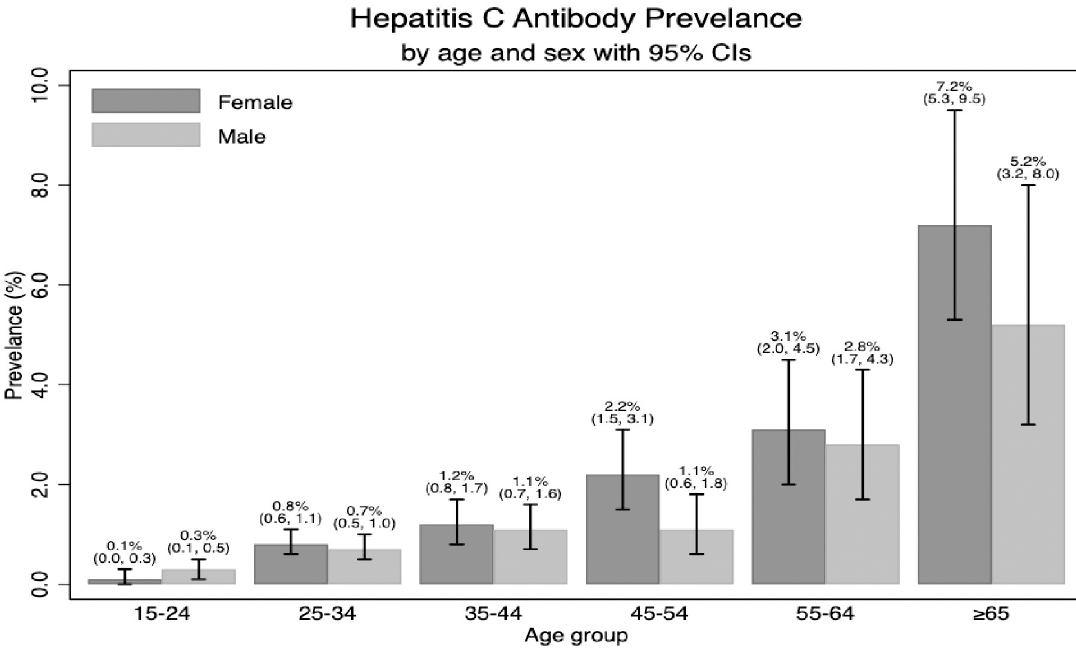
Fig 2. Hepatitis C antibody prevalence by age and